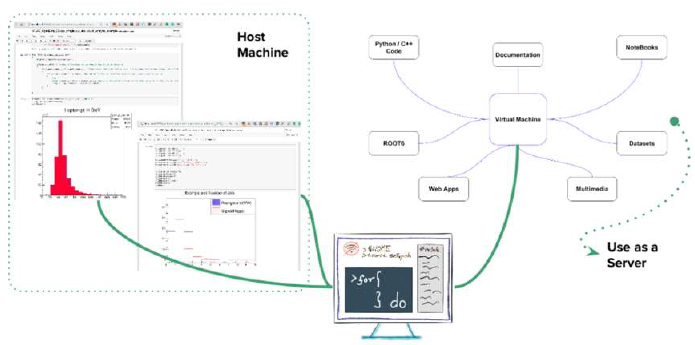
Figure 5. Illustration of a VM running as a server, where the applications are opened in the browser of the host